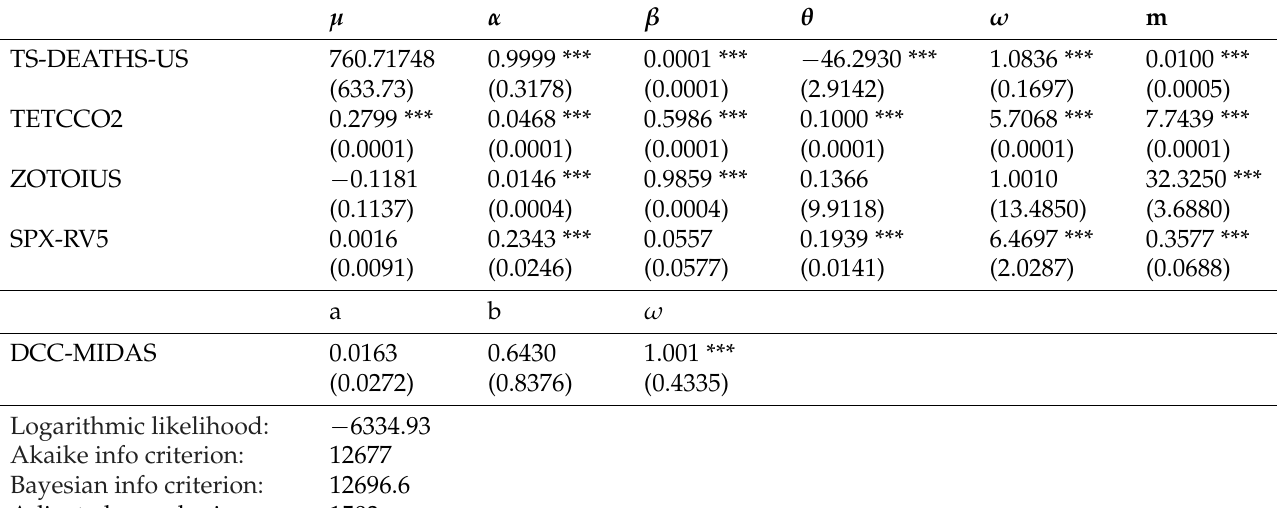
Table 5. Dynamic Conditional Correlation with Mixed Data Sampling (DCC-MIDAS) estimates when introducing COVID-19 deaths to the baseline composed of Total Fossil Fuels CO 2 emissions, Total Industrial Production Index, and S&P 500 Index. µ